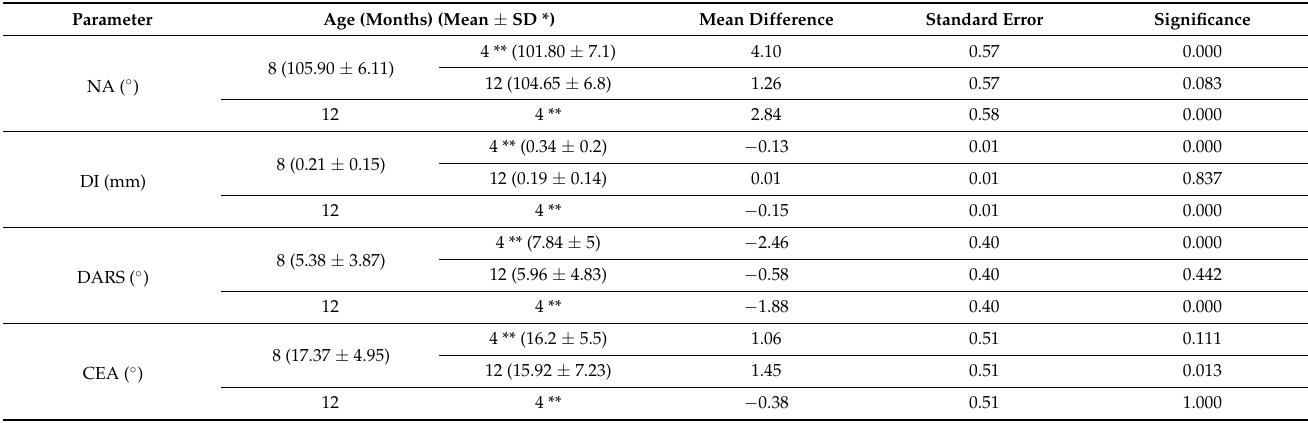
Table 1. Multiple comparisons of measurements of quantitative values with mean differences